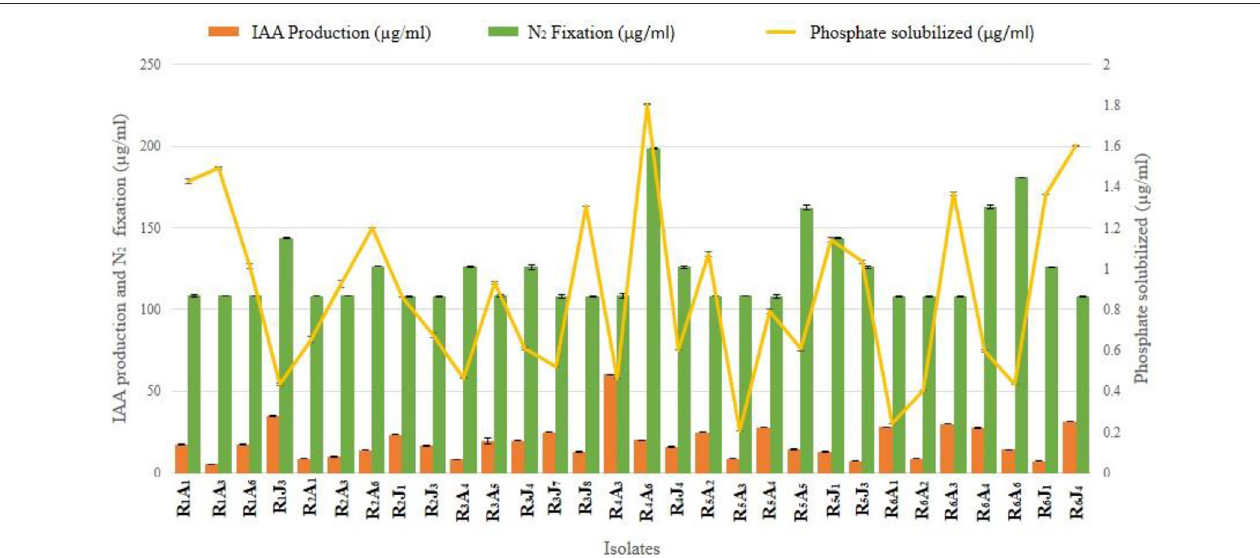
FIGURE 2 | A representative illustration of in vitro plant growth-promoting traits of 30 endophytic PGPR isolates shortlisted from seventy-five, that showed an elevated level of productivity [Nitrogen fixation (108–198.7 µ g/ml), Phosphate solubilization (0.2–1.8 µ g/ml), and IAA production (5.4–60.1 µ g/ml)]. Error bars represent the mean ± SD ( n =